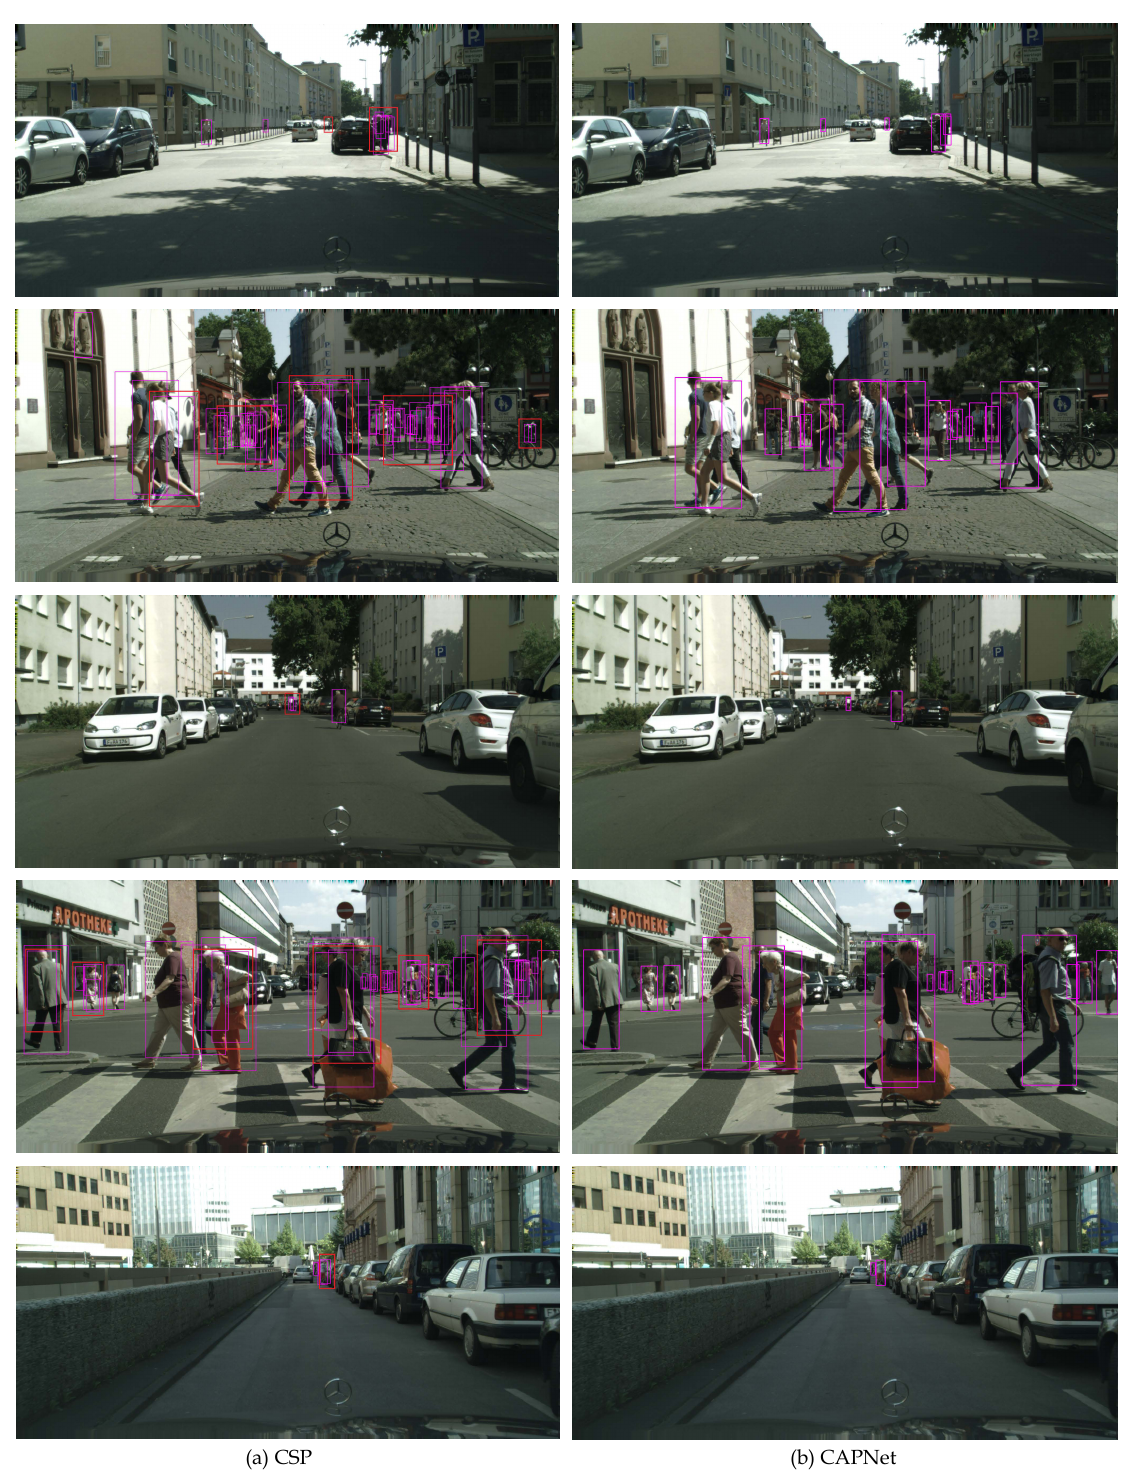
Figure 4. The detection results of the same five images in the validation set on CSP and CAPNet. The area framed by pink boxes is detections output by the two detectors. The area framed by red boxes is negative proposals detected by